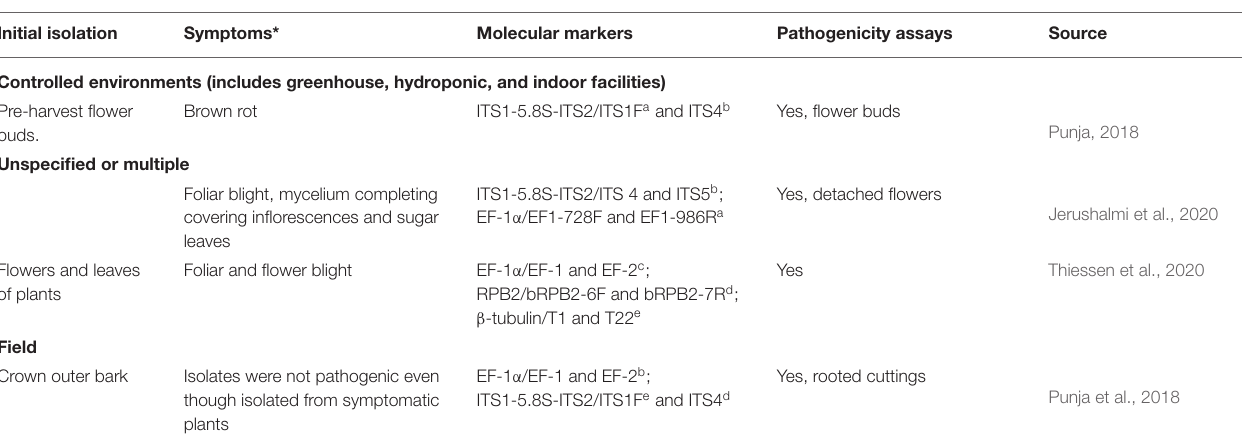
TABLE 4 | Diseases reported in C. sativa caused by Fusarium equiseti